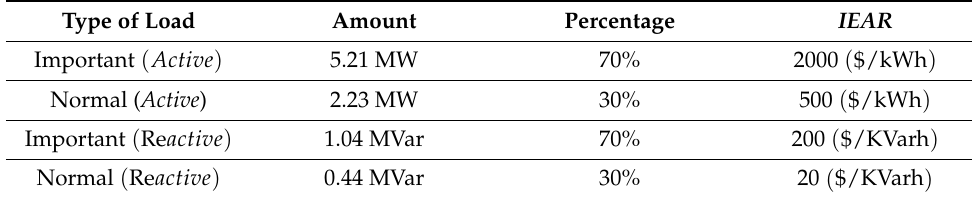
Table 2. Initial network load